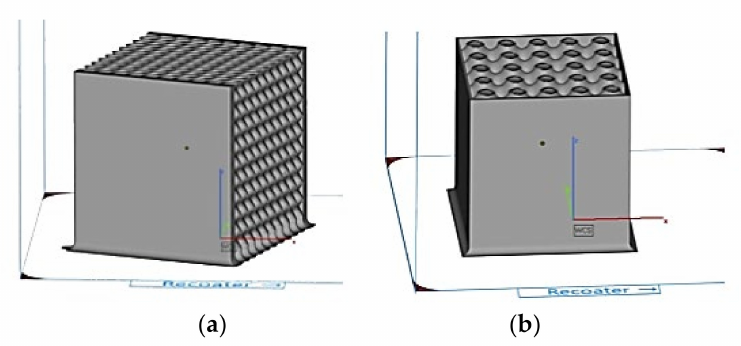
Figure 3. Build orientations of ( a ) specimens with end-plates, and ( b ) specimens enclosed in tubes.